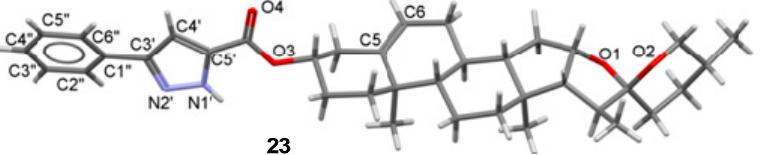
Figure 4. The molecular structure of pyrazole 23 . The thermal ellipsoids are drawn at the 30% probability level.